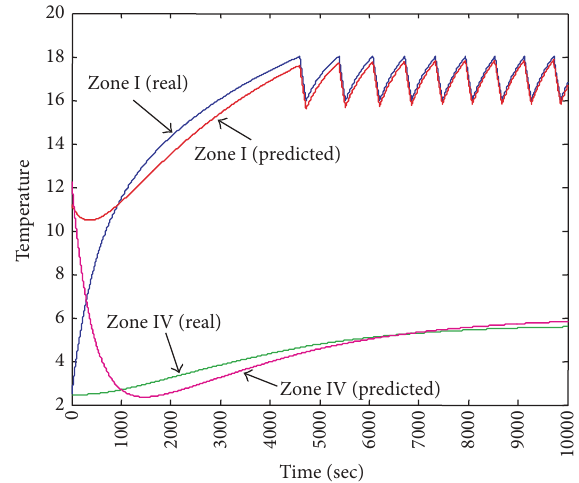
Figure 7: Real and predicted temperature of zones I and